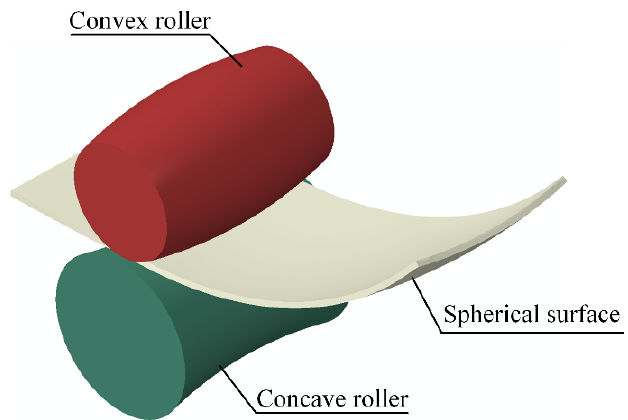
Figure 1. 3D curved parts formed by arc-shaped rollers.